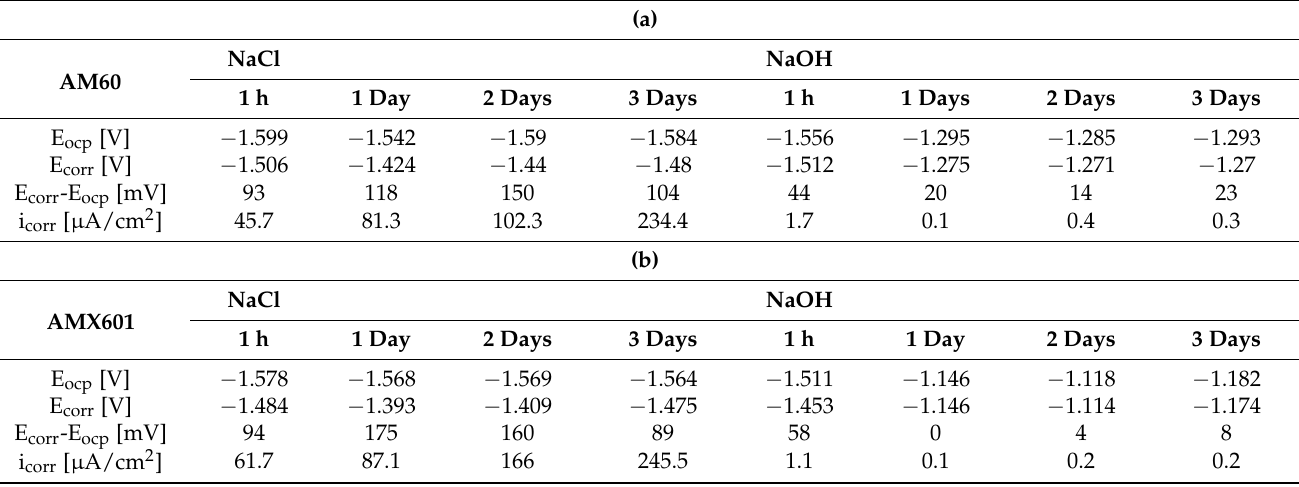
Table 2. ( a ). The electrochemical parameters obtained from PDP (potentiodynamic polarization) curves of AM60 alloy. ( b ). The electrochemical parameters obtained from PDP curves of AMX601 alloy. E ocp: open circuit potential. E corr corrosion potential. i corr: corrosion current